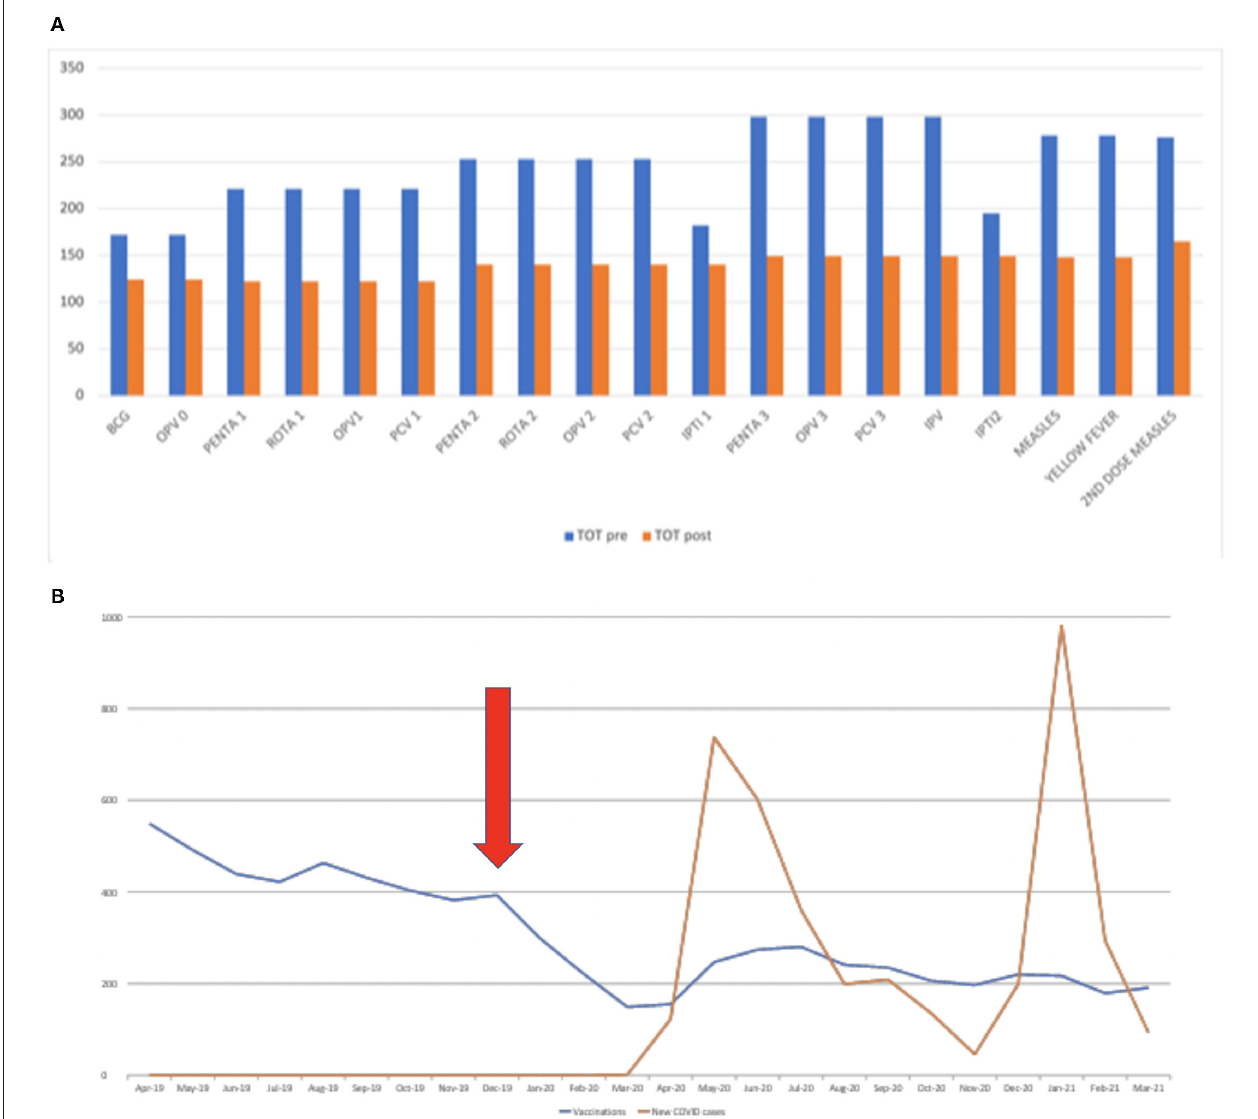
FIGURE 1 | (A) Total number of immunizations delivered during the pre- and post-pandemic study periods. The data shows the absolute number of vaccines performed in the first and second year analyzed. In 2020 the number of vaccines performed appears visibly reduced and the different vaccines have undergone different deflections with the less affected which seem to be those performed at birth (BCG and OPV0) and IPTI 1 and 2. (B) Overall trend of the administered immunizations according to local SARS-CoV-2 cases and the first detection of SARS-CoV-2 in China. The figure shows how clearly immunizations dropped as soon as the first cases have been notified, before the first cases detected in Sierra Leone. The arrow shows the period in which the first cases were described in China.